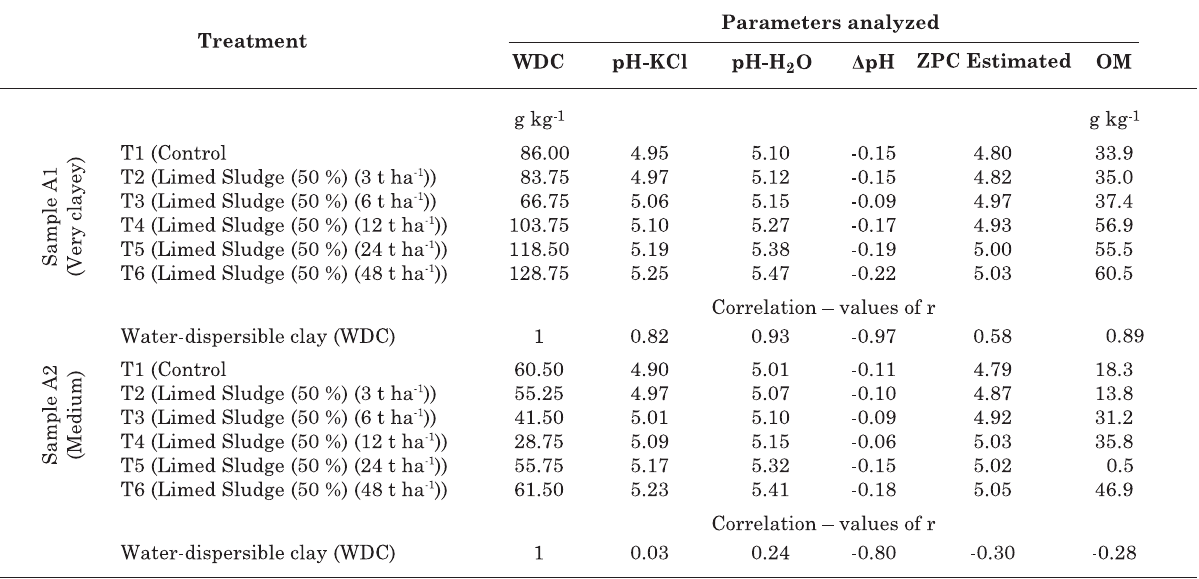
Table 2. Average values (for 20 replications per treatment) for WDC (water-dispersible clay), pH-KCl and (A2) after 180 days of incubation in pots kept in a greenhouse. Pearson linear correlation coefficient (r) between WDC and other parameters analyzed